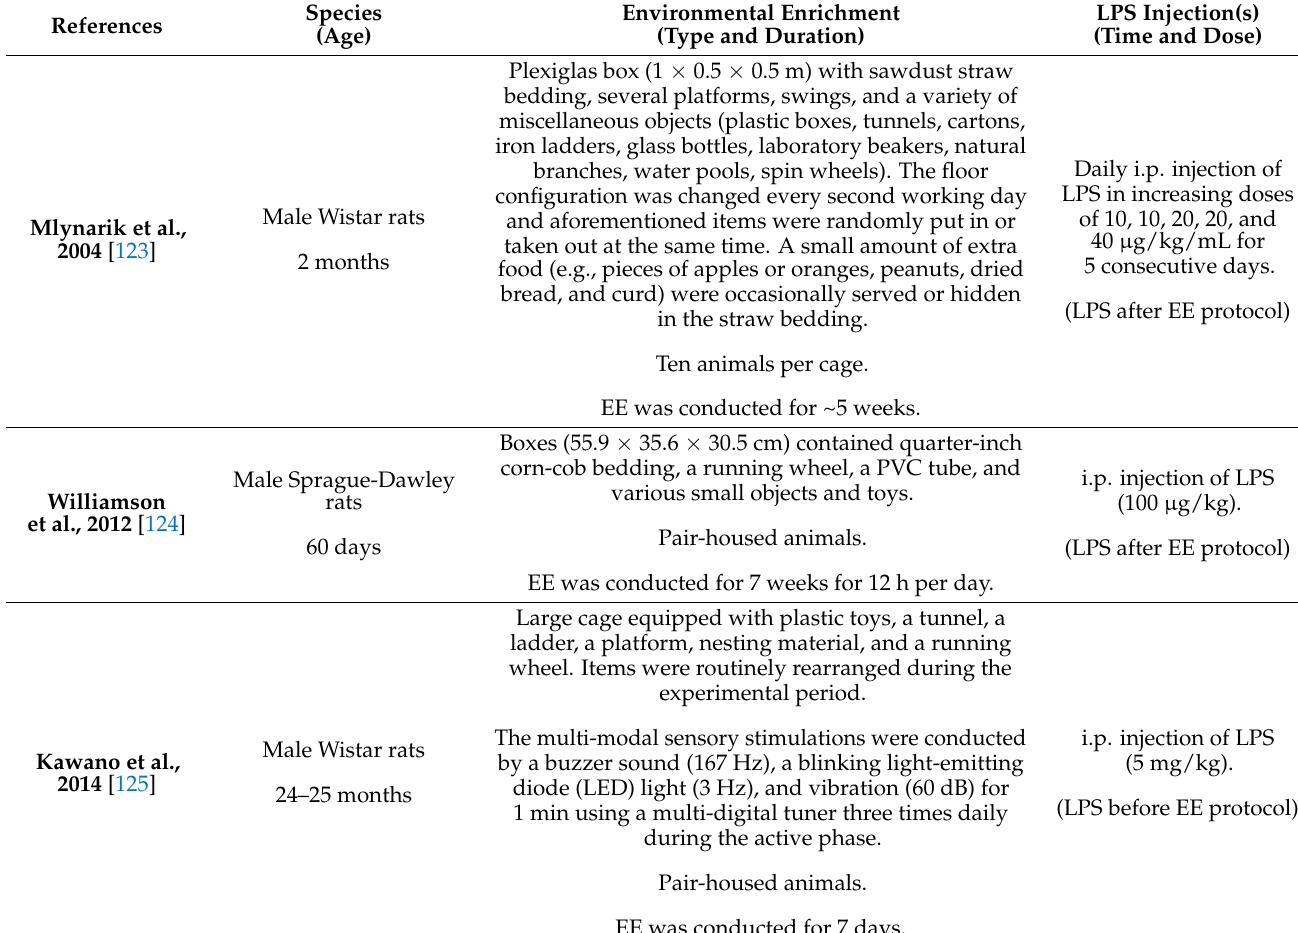
Table 5. Inflammation in adulthood—study